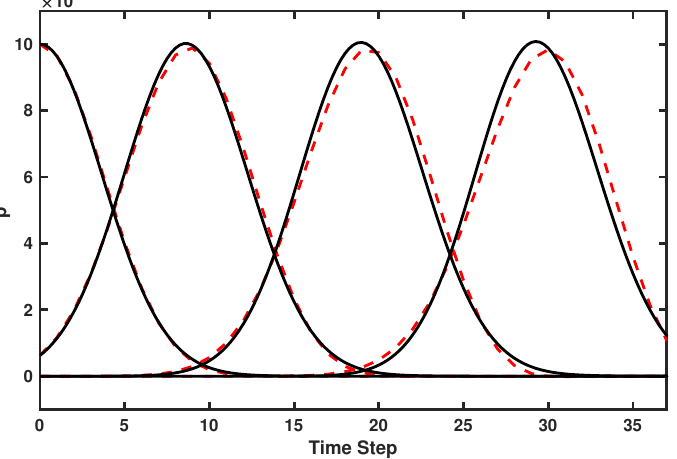
∆ x 2 ∆ t ) with σ = 0.1: